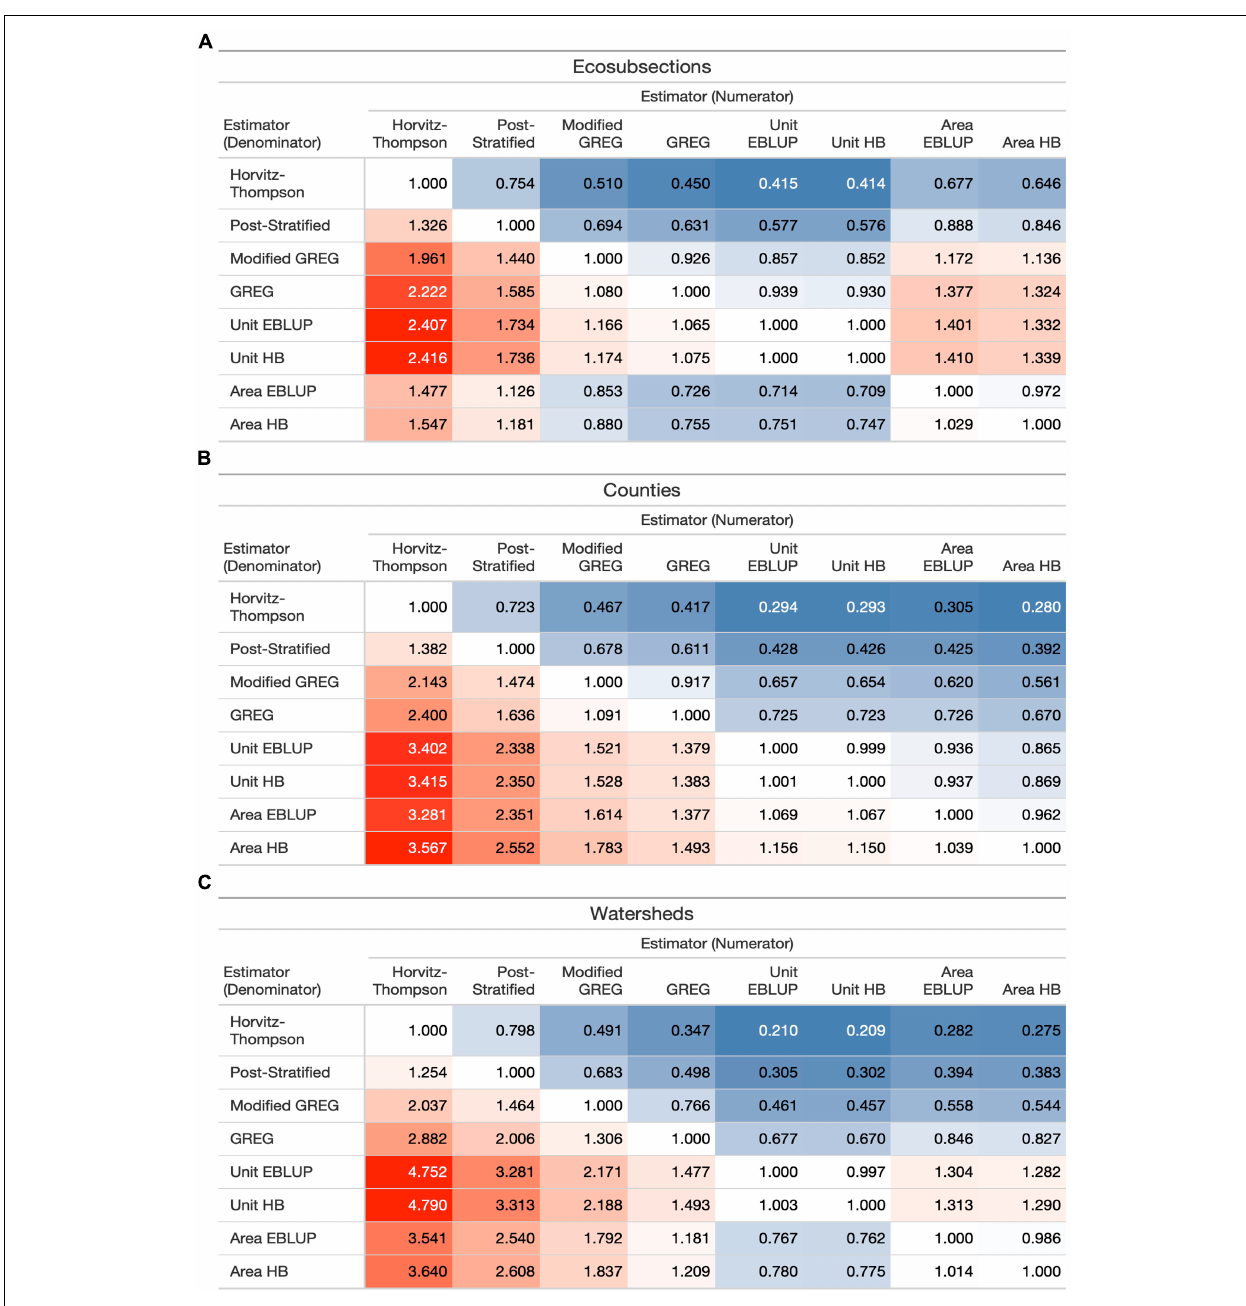
FIGURE 7 | The relative efficiency of each of the eight estimators for basal area averaged over (A) ecosubsections, (B) counties, and (C) watersheds for the entire study region. Numbers in each cell reflect the variance of the estimates derived under the estimator named in the column divided by the variance of the estimator named in the row. Shades of blue reflect values less than 1, with the deepest blue set at the minimum value for that specific table. Conversely, shades of red reflect values greater than 1 with the deepest red set at the maximum value for that specific